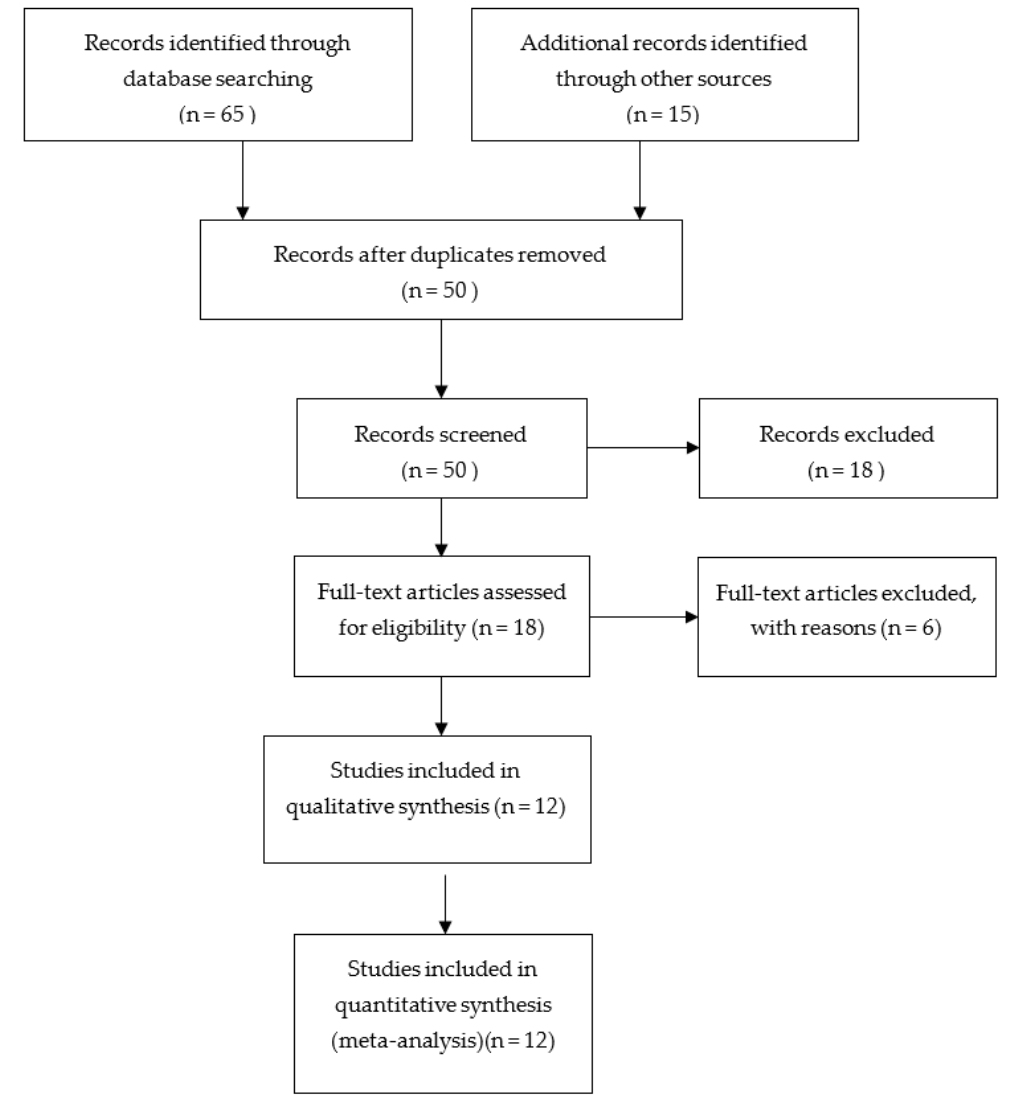
Figure 1. PRISMA diagram showing study screening process. There were 6686 patients in total among 12 studies who were eligible. These studies were published from 2014 to 2021 and were conducted in Ethiopia ( n = 8, 9.2% [1,18–24]), Cameroon ( n = 1, 19% [25]), China ( n = 1, 15.55%; [26]), Tanjaznia ( n = 1, 14.44% [27]), and Uganda ( n = 1, 8.25% [28]). Figure 2 shows additional quality scores for included